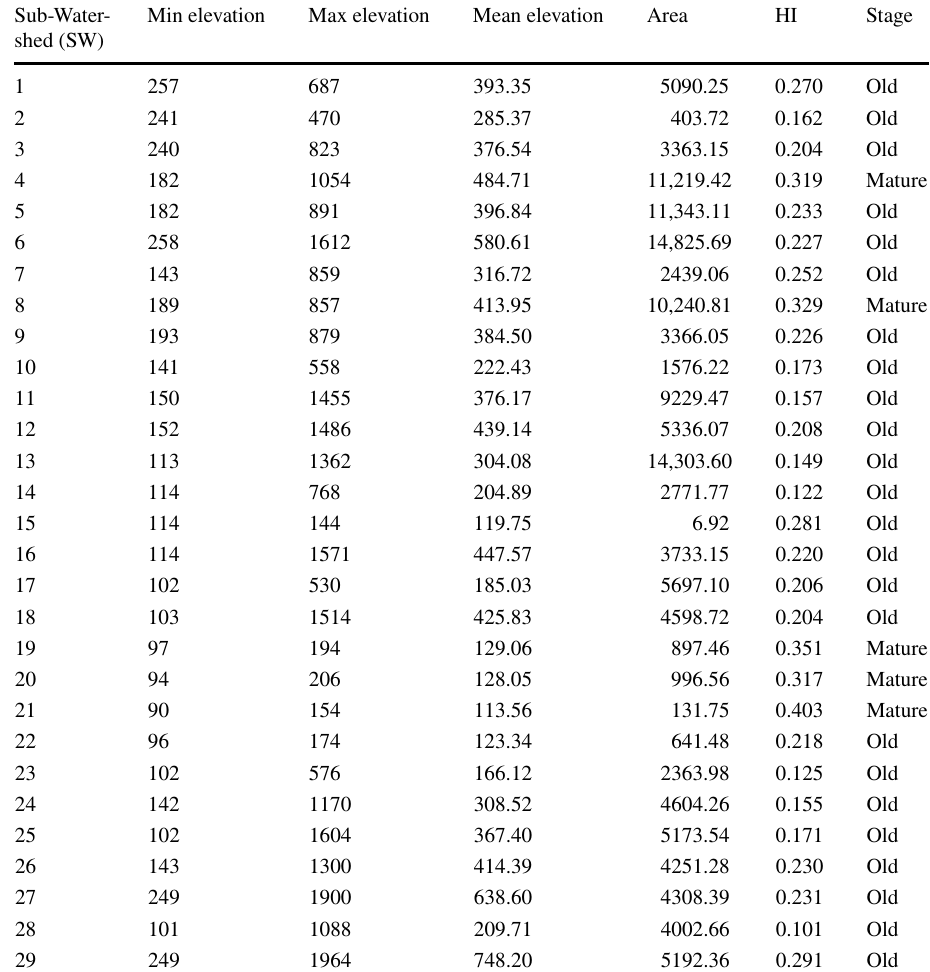
Table 8 Hypsometric Integral